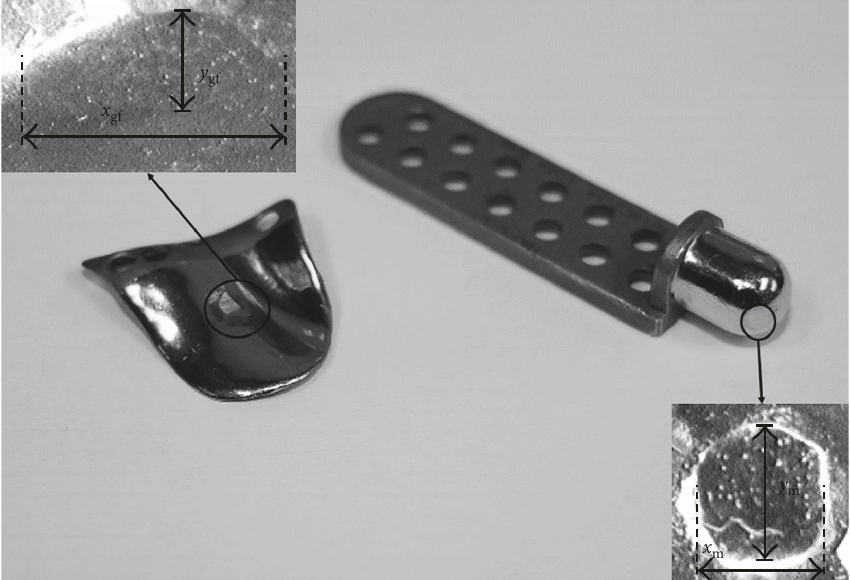
Figure 5: Evaluation of the damaged zone within the contact interface of a resected after failure Christensen TMJ prosthesis specimen by